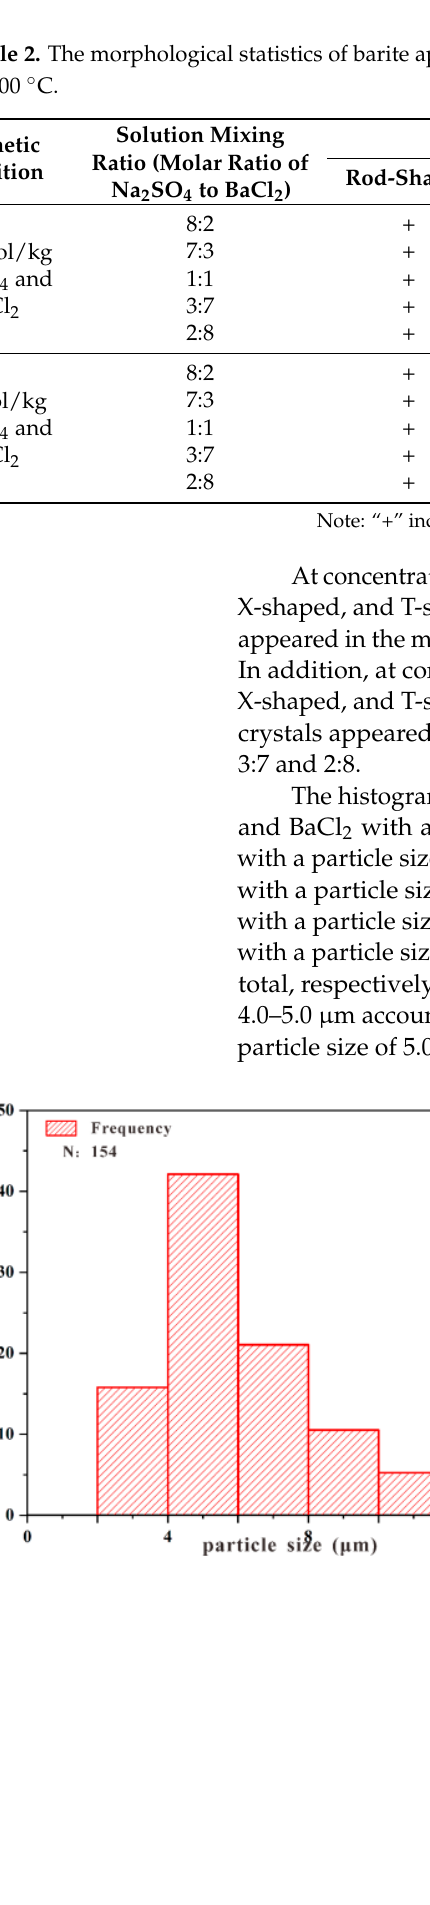
Figure 3. Histograms of the barite particle size with different morphology. The barite was syn- thesized using a mixed solution of 0.03 mol/kg Na 2 SO 4 and BaCl 2 with a ratio of 2:8 at 200 °C. ( a ) plate-shaped ( b ) rod-shaped ( c ) granular ( d ) dendritic ( e ) T-shaped ( f ) X-shaped. N: statistic. 3.2. Morphology of Barite Synthesized at Room Temperature When the initial ion concentration is constant, the morphologies of the barite synthe- sized at room temperature with different mixing ratios are the same, and the change of the mixing ratio does not change barite morphology (Figure 4). The morphology of barite is leaf-like when the initial concentration of Na 2 SO 4 and BaCl 2 solution is 0.03 mol/kg; the morphology of barite consists of nanospheres when the initial concentration of Na 2 SO 4 and BaCl 2 solution is 0.1 mol/kg. And the particle size distribution of barite synthesized by mixed solutions at room temperature shows a normal distribution (Figure 5).